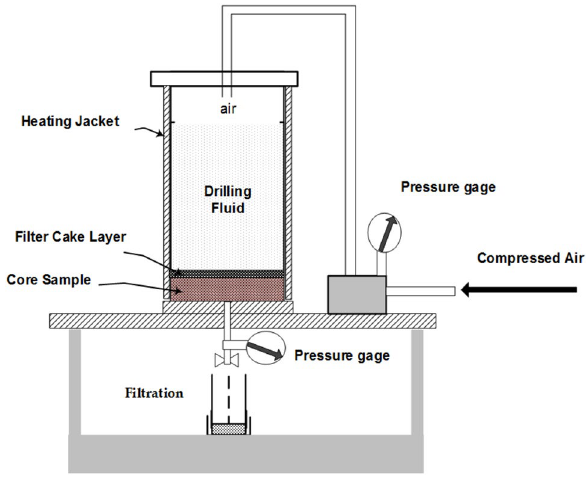
Fig. 2 Assembled high-pressure high-temperature fluid loss system to form filter cake